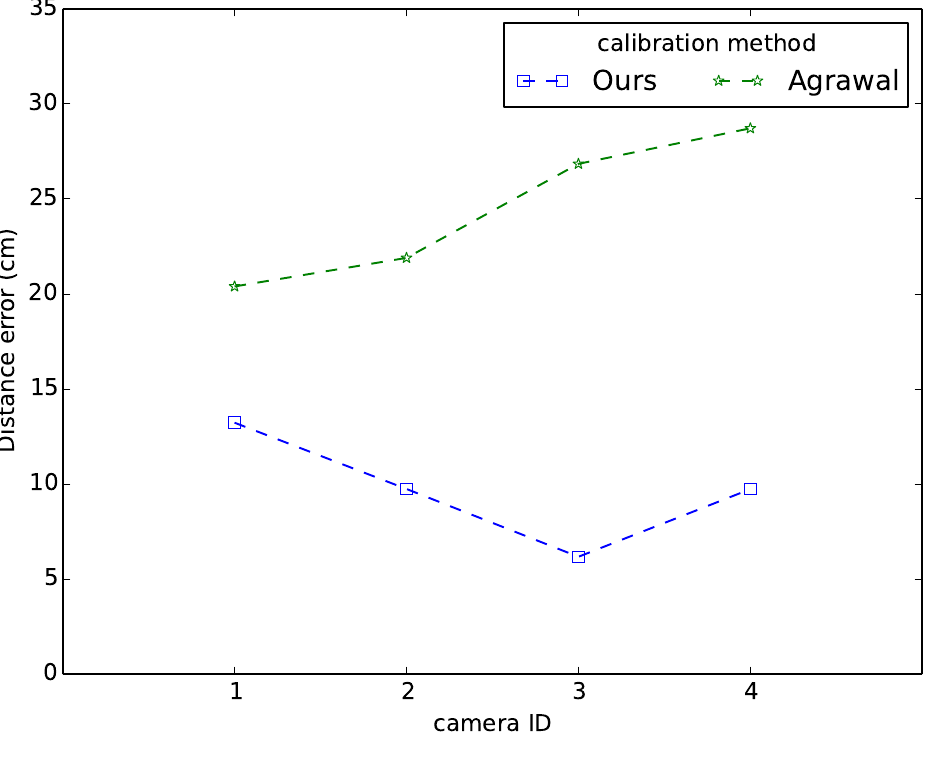
Figure 3. Mean distance error comparison.